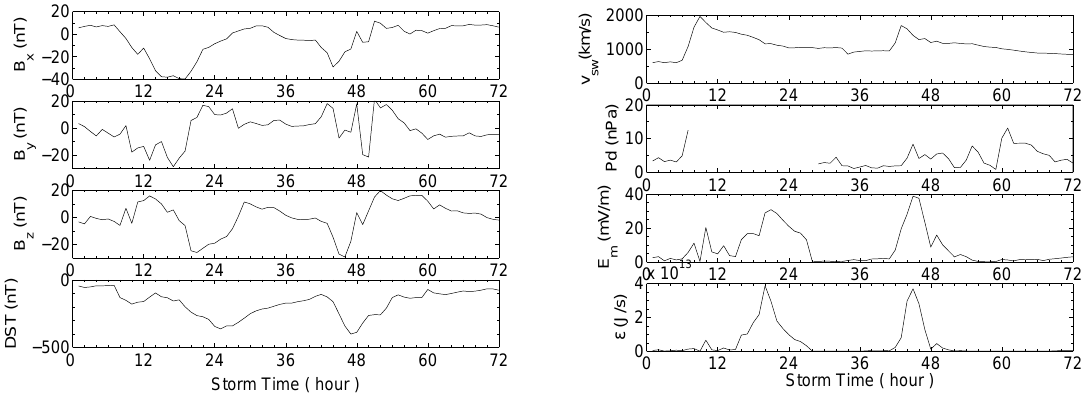
Fig. 1. Typical storm-time solar wind parameters, including IMF B x , B y , B z components in GSM coordinate system, velocity, v sw , dynamic pressure, P d , merging electric field, E m , Akasofu parameter, ε , and D st variations on 29–31 October 2003.